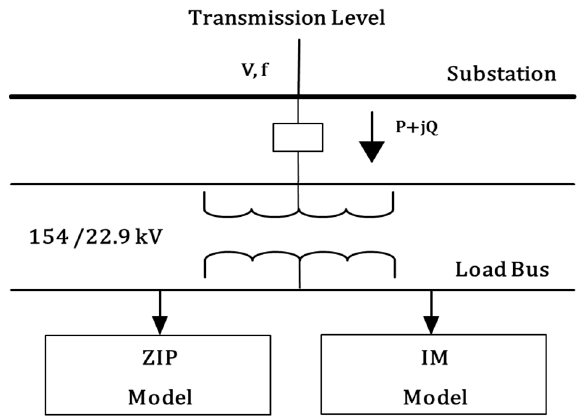
Figure 1. Composite load model (Constant impedance-current-power + Induction Motor).